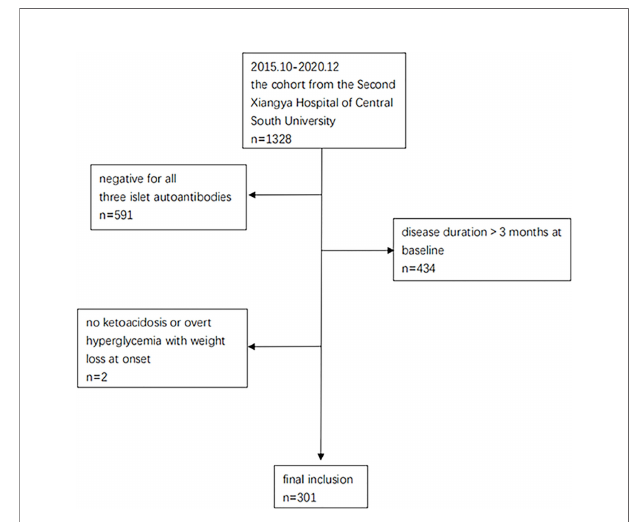
FIGURE 1 | Enrollment fl ow chart of the